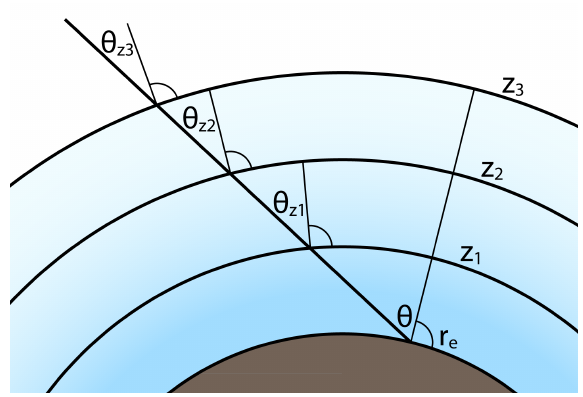
Figure 2. Spherical geometry of the Earth’s atmosphere with the Earth’s radius r e , the (solar or satellite) zenith angle θ at the surface and at the heights z 1,2,3